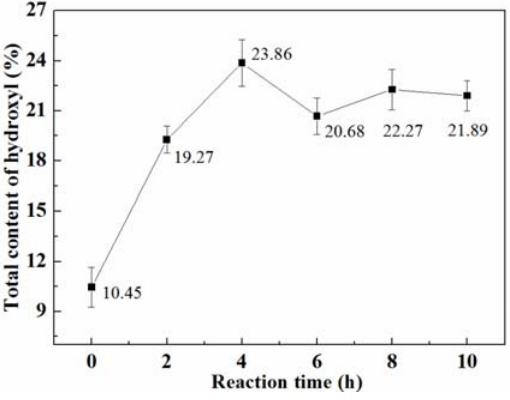
Figure 2. Total content of hydroxyl groups of lignin treated with glyoxal at different reaction times.